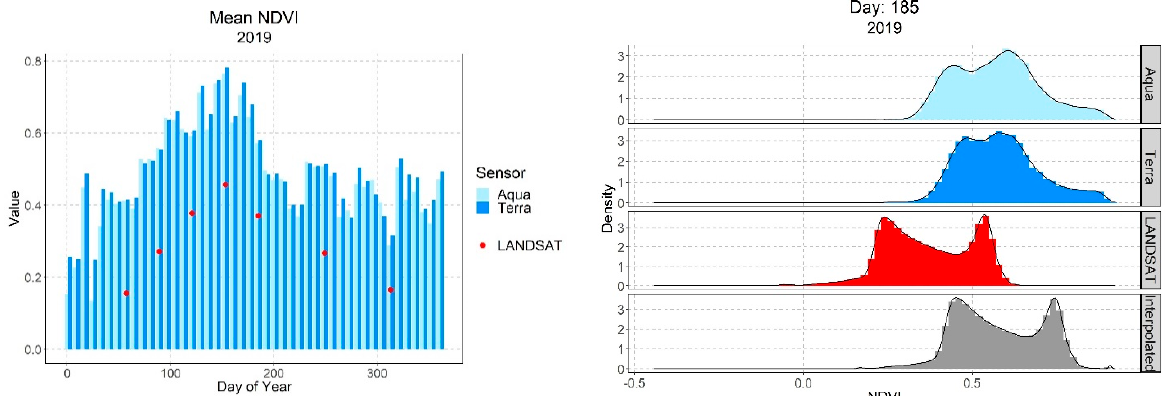
Figure 6. Variation in NDVI by day and sensor ( left ); density plots of NDVI by sensor on day 185 and the interpolated NDVI used for creation of the DisTrad LST ( right ).